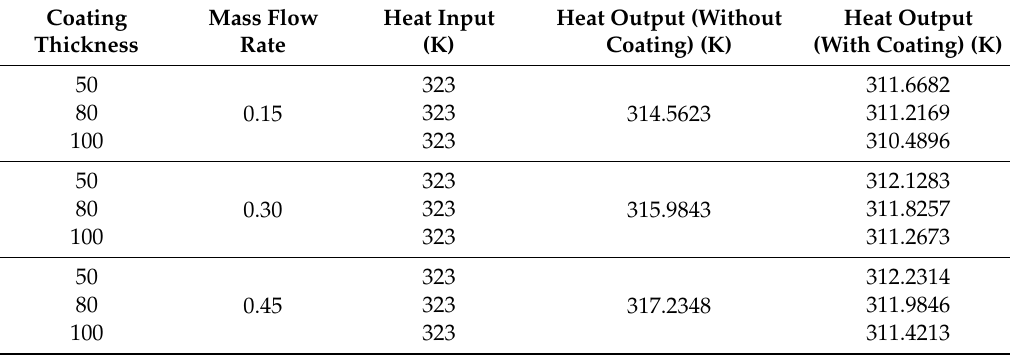
Table 7. CFD Analysis Reading for 323